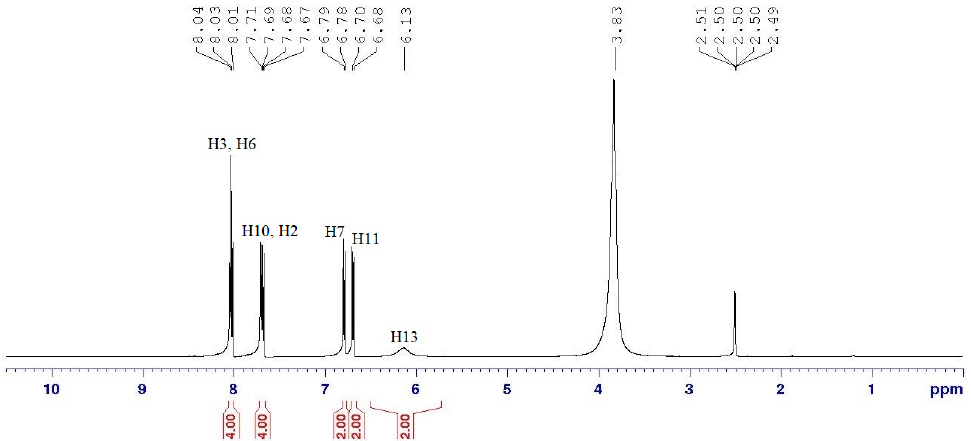
Figure 8. 1 H-NMR spectrum of compound 8j .